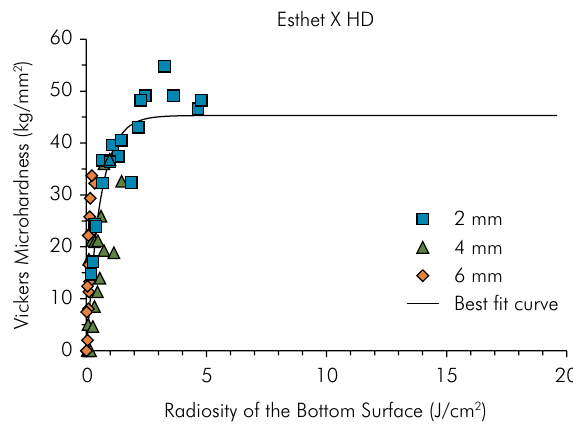
Figure 2. Non-linear regression of Radiosity of the Bottom Surface (J/cm 2 ) and Vickers Microhardness (kg/mm 2 ) for Tetric EvoCeram Bulk